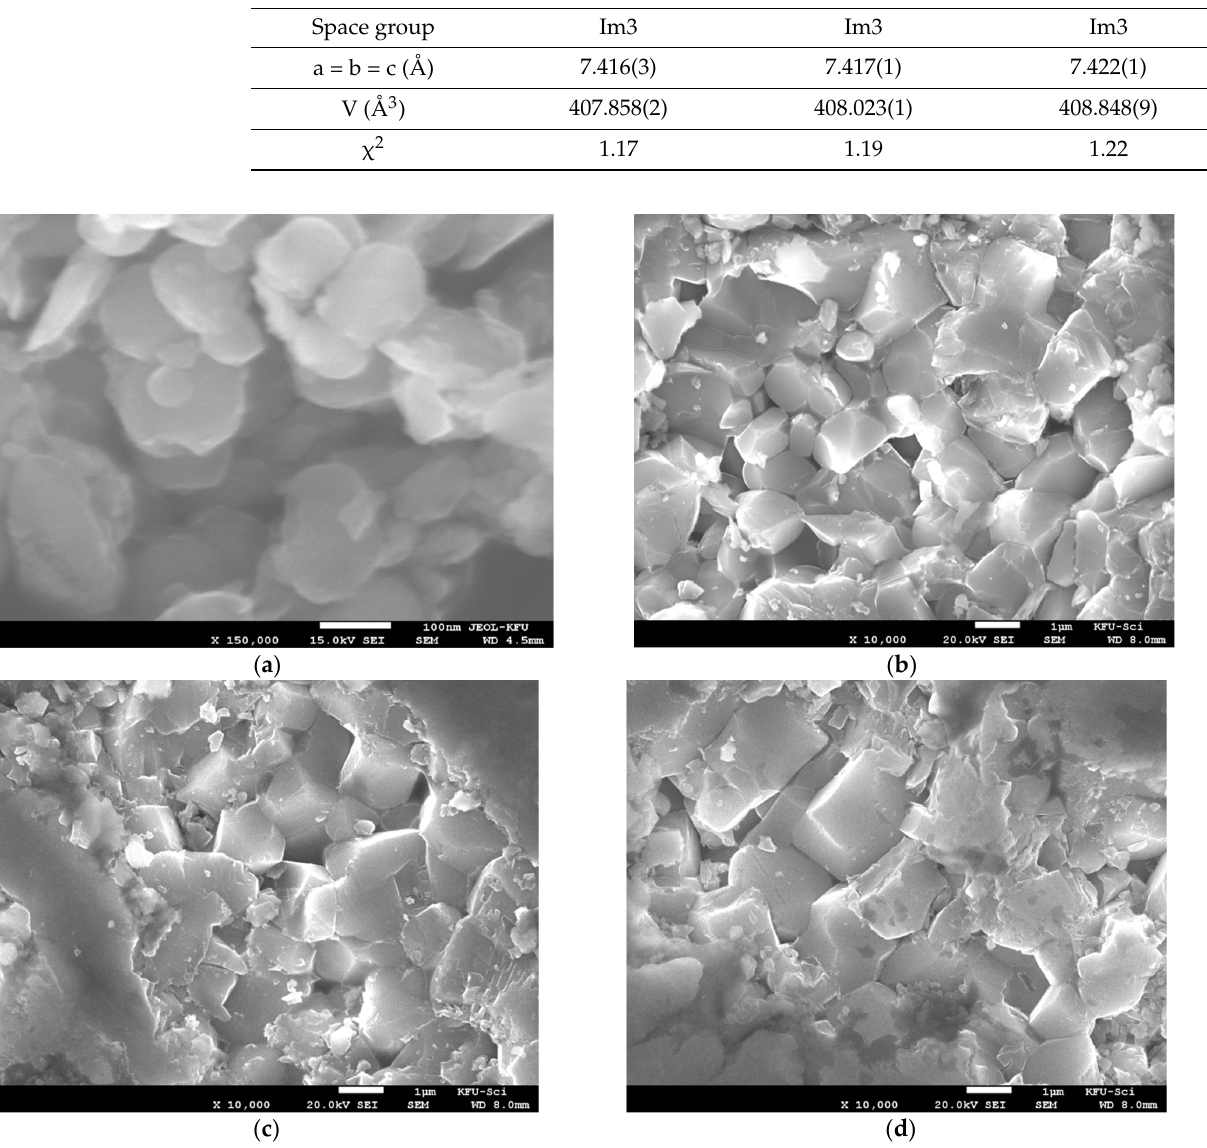
Figure 3. FE-SEM micrographs of ( a ) LCTO powder and ( b ) CS-975, ( c ) CS-1000 and ( d ) CS-1025 LCTO ceramics.